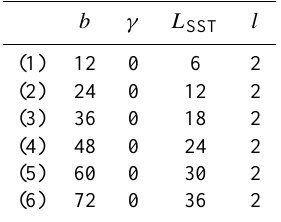
Fig. 16. w-correlation with the 24 reconstructed time series. (a) Nakuru, (b) Naivasha, (c) Narok, and (d) Kisumu. When the mode for the reconstructed time series is higher, the separability becomes weaker because more different color cells indicating the correlation with other modes are illustrated in the row and column directions of each reconstructed time series in the results. b : a Table 4. Parameter combinations of the precipitations for SST. time length of both past and future parts, (cid:13) : a start position of the subtime series in the future part from the reference time, L SST : a window length for these subtime series, l : the number of the left singular vectors of the past part to span a hyperplane. Fig. 19. IOD and the two representative time series (trend and har- Fig. 19. IOD and the two representative time series (trend and har- monics) of the monthly precipitations from 1950 to 1985. This monics) of the monthly precipitations from 1950 to 1985. This study focuses on the events of IOD around the early 1960s showing study focuses on the events of IOD around the early 1960’s show- the change from the negative mode to the positive mode. At that ing the change from the negative mode to the positive mode. At that time, the precipitations in all the stations immediately increased ac- time, the precipitations in all the stations immediately increased ac- cording to the trend time series and the periodicity is changed from a cording to the trend time series and the periodicity is changed from 12-month cycle to 6-month cycle in Nakuru, Naivasha, and Kisumu 12-month cycle to 6-month cycle in Nakuru, Naivasha, and Kisumu according to the harmonics time series (see Table 5). according to the harmonics time series (see table 5).